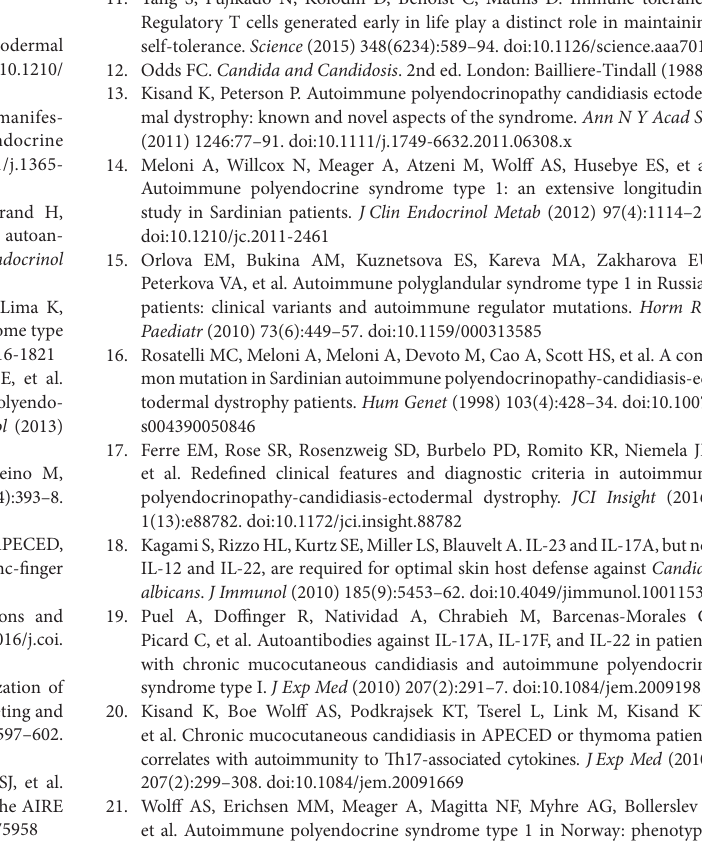
FigUre s1 | Functional annotation of the protein profile characterizing the altered immune response to C. albicans in APS-1 patients versus healthy individuals. This protein:gene-ontology-(GO) term network identified four clusters of biological processes, each with its leading term, that most efficiently interconnect the nine proteins here relevant. Any regulatory relationships between the proteins, as per CluePedia v10.0 are displayed as well. FigUre s2 | Gating strategy for flow cytometric